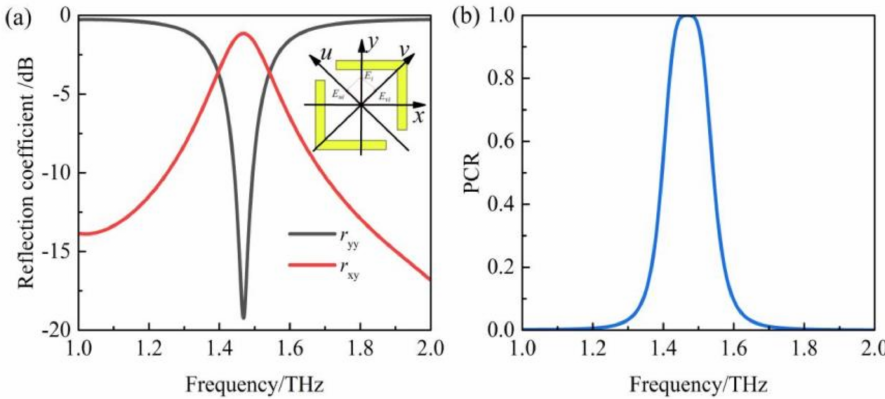
Figure 5. The relation between the reflection coefficient ( a ) and polarization conversion efficiency ( b ) of the polarization converter and frequency.